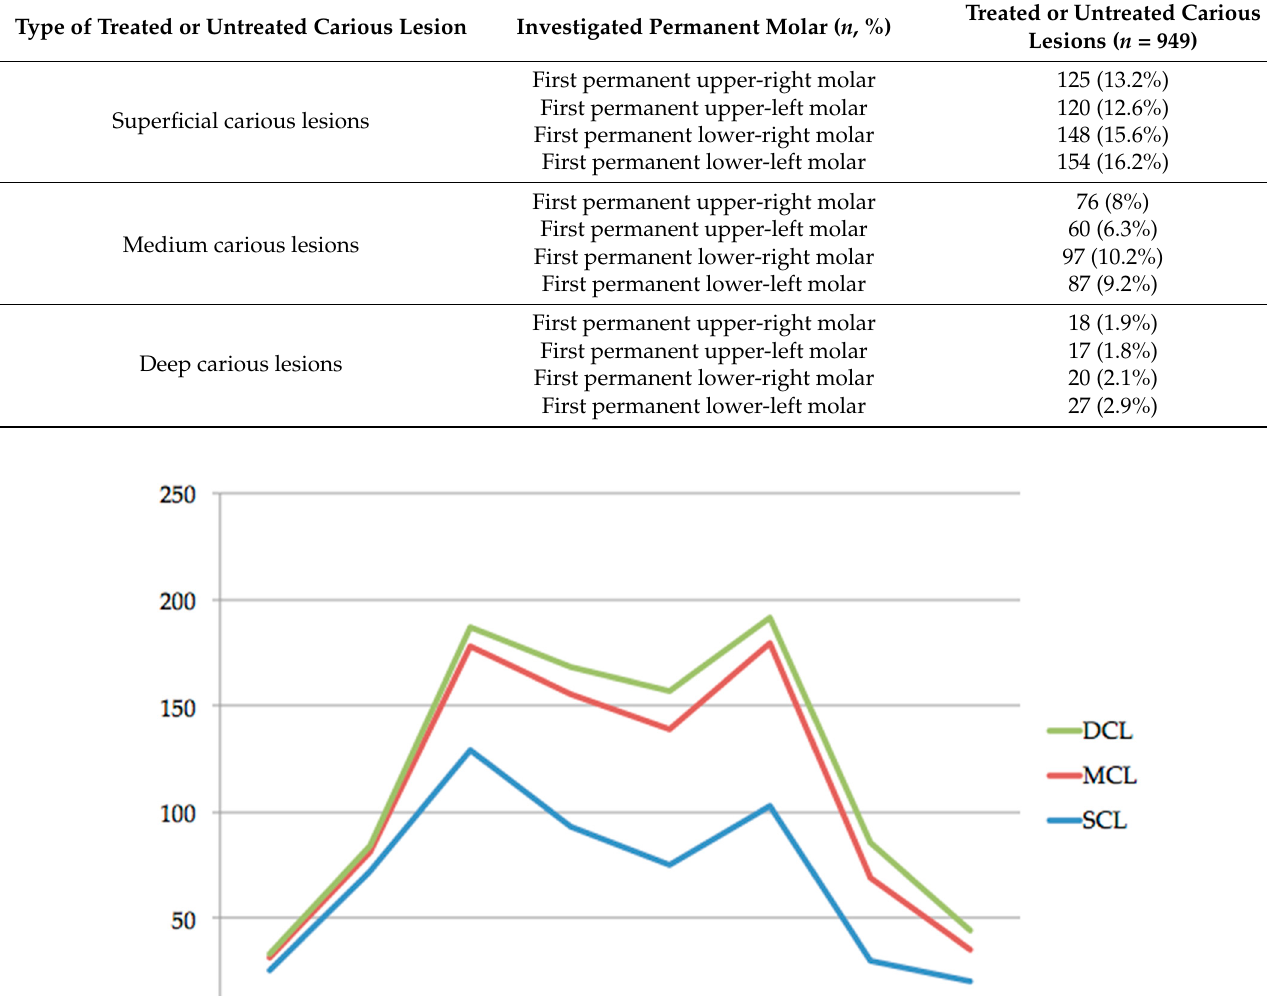
Table 1. Distribution of identified carious lesions.